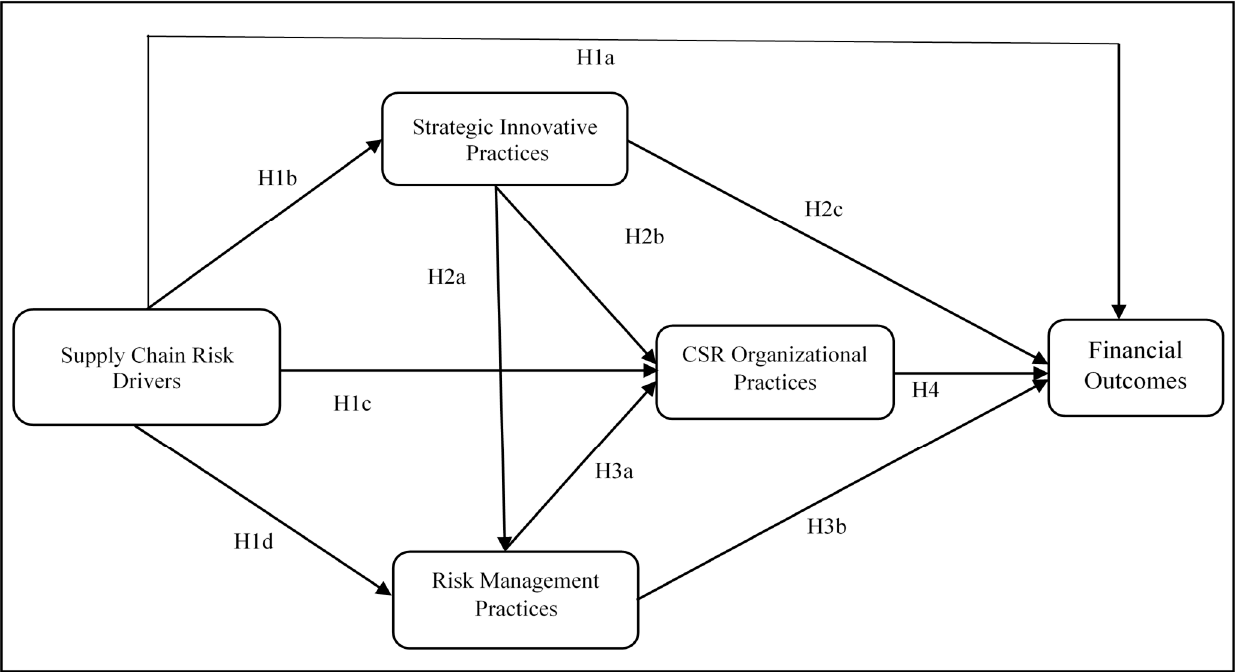
Figure 2. Theoretical